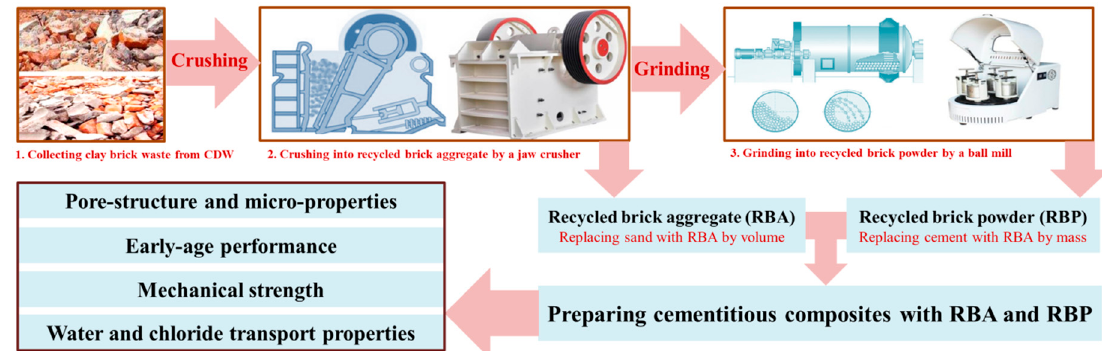
Figure 1. Investigating and testing process of this work.